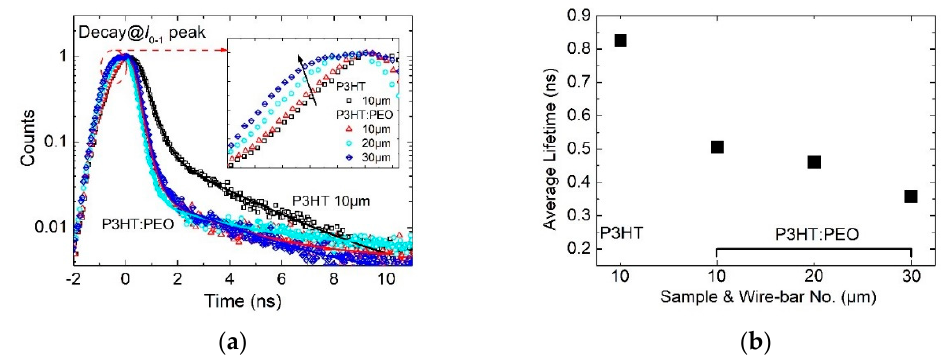
Figure 4. ( a ) Time-resolved PL spectra of poly (3-hexylthiophene-2,5-diyl) (P3HT) and P3HT: poly (ethylene oxide) (PEO) wire-bar-coated film with the excitation at 405 nm. Rising edges are magnified to provide the inset in ( a ). ( b ) Average lifetimes deduced from ( a ) are plotted as the function of bar sizes.